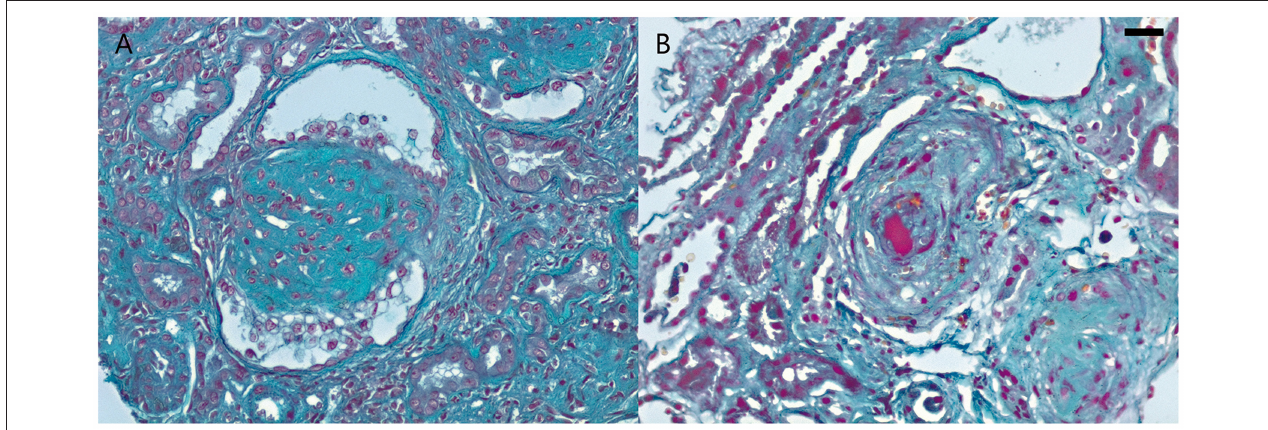
FIGURE 4 | Renal morphologic patterns in COVID-19 patients from Empresa Brasileira de Serviços Hospitalares (EBSERH) network. (A) Needle biopsy in a male patient (aged 43 years) shows glomerulus with tuft collapse and overlying epithelial hypertrophy and hyperplasia compatible with collapsing glomerulopathy